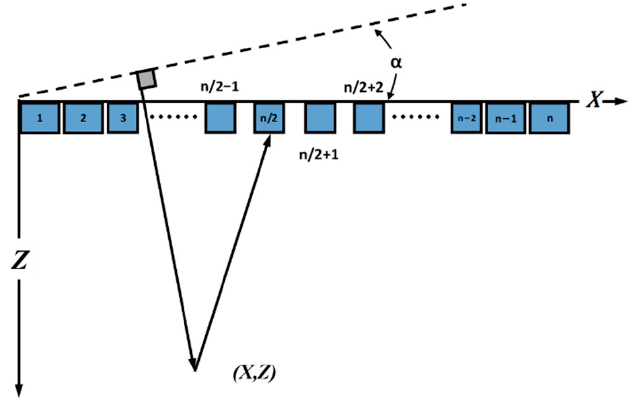
Figure 4. The geometric coherent plane wave compounding (CPWC) relationship that the MNULA satisfies. The plane wave is with an angle α .